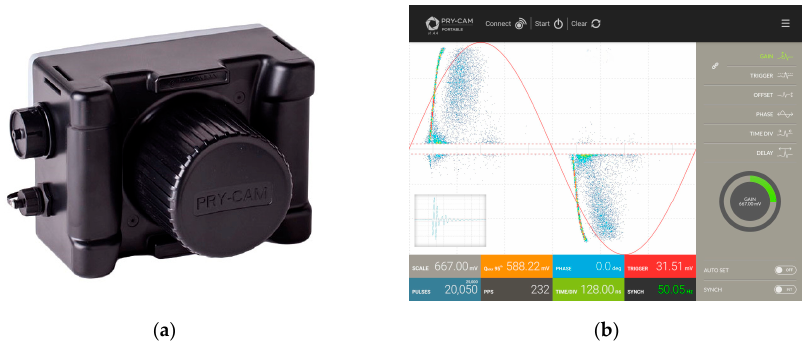
Figure 1. ( a )Pry-Cam TM Portable and ( b )a screenshot of the software interface. Figure 1. ( a ) Pry-Cam TM Portable and ( b ) a screenshot of the software